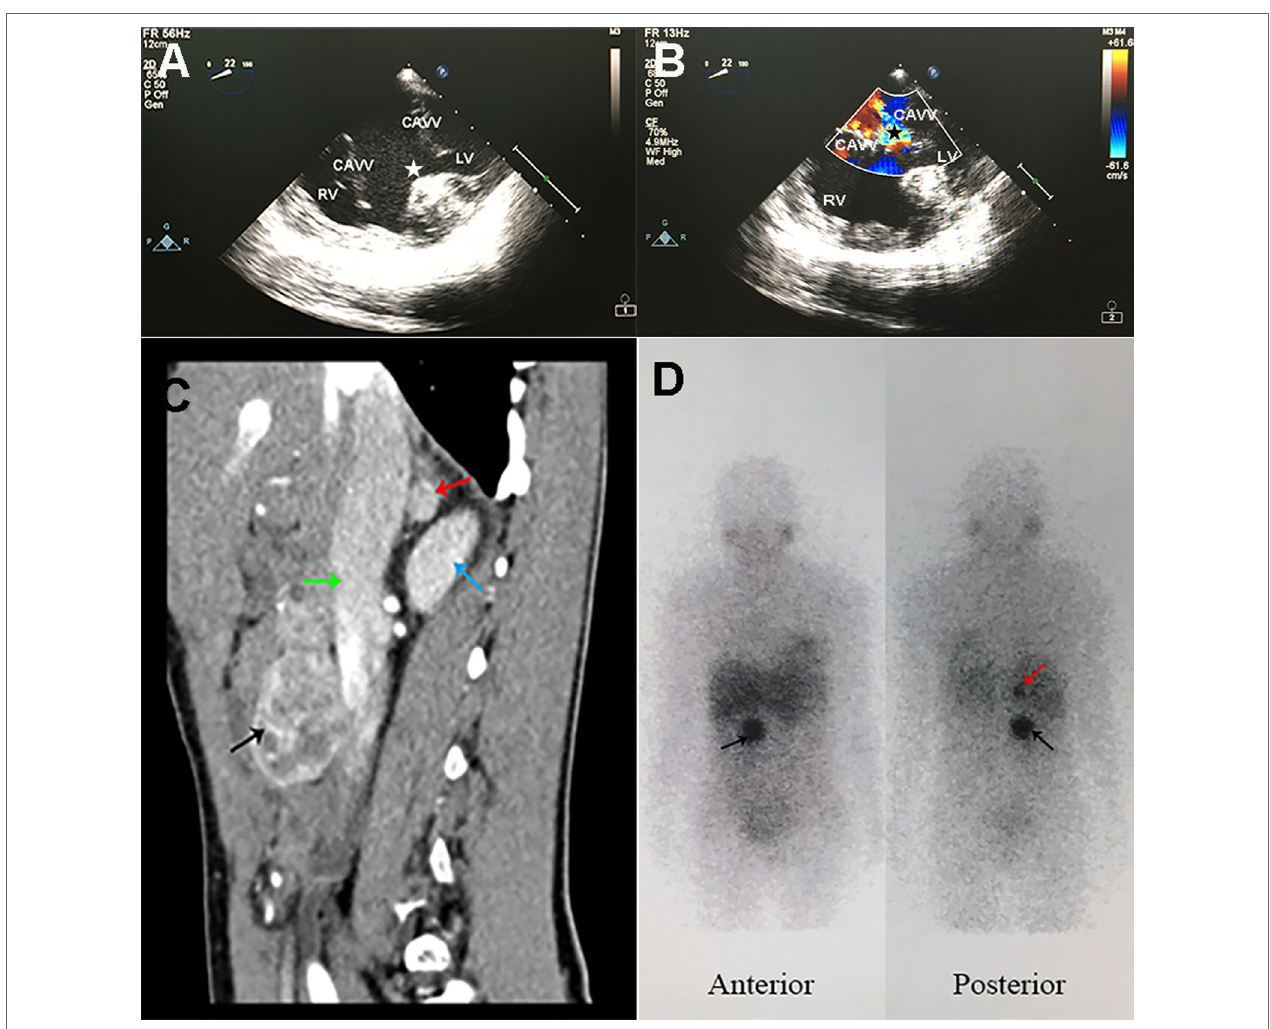
FIgURe 1 | Specific radiographic imaging of the patient. (a,B) Trans-esophageal echocardiography showed functional single ventricle and severe common atrioventricular valve regurgitation. (a) CAVVs were open in cardiac diastole, and huge ventricular septal defect (white star) was observed. (B) CAVVs were closed in cardiac systole and regurgitation of blood into the ventricle (black star) was observed. RV, right ventricle; LV, left ventricle; CAVV, common atrioventricular valve. (C) Contrast-enhanced computed tomography sagittal reconstruction image of the abdomen showed a rounded mass (1.1 cm × 1.1 cm × 1.1 cm) in right adrenal gland (red arrow) and another mass (4.4 cm × 3.2 cm × 4.3 cm) with mixed density (black arrow) anterior to inferior vena cava (green arrow) at L2–3 lumbar level. The right kidney was showed with blue arrow. (D) 123 I-MIBG scintigraphy showed intense uptake in the right adrenal gland (red arrow) and in front of the inferior vena cava (black arrow) at L2–3 lumbar